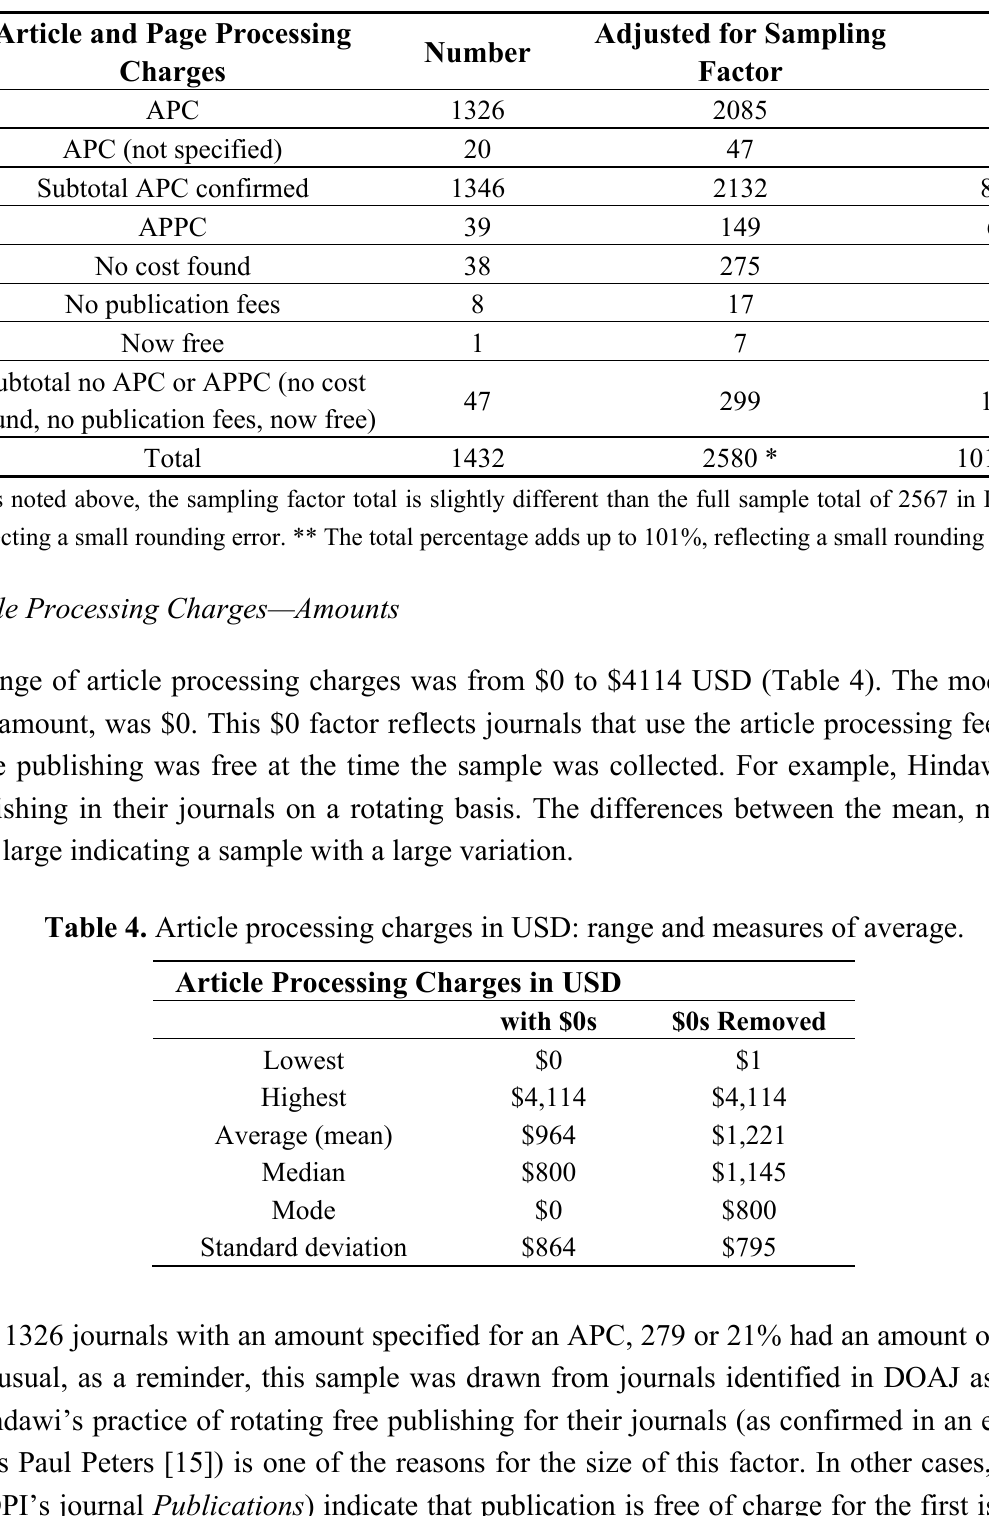
Table 3. Article versus page processing charges.